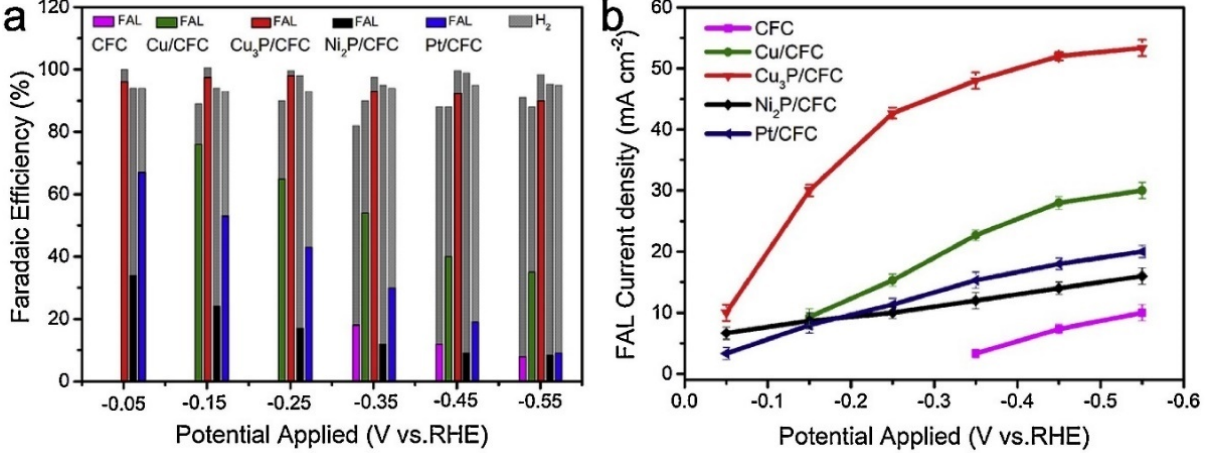
Figure 10. The ECH of furfural over different electrodes: ( a ) the FAL and H 2 Faradaic efficiency, ( b ) the FAL partial current density at different applied potential measured in N 2 -saturated 1 M KOH solution with 50 mM furfural in the working electrode reaction tank. Reprinted with permission from Ref [99]. Copyright 2019 Elsevier Inc.